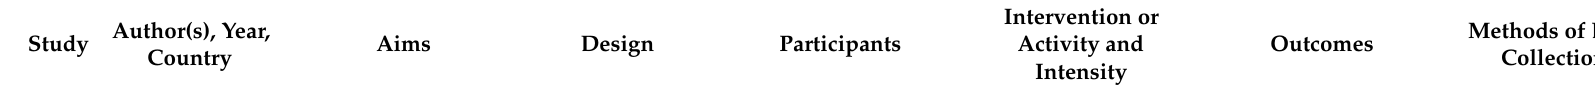
Table 2. Summary information of included